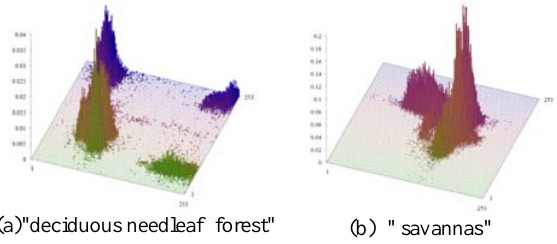
Figure 7. Examples of obtained time-domain co-occurrence matrix.